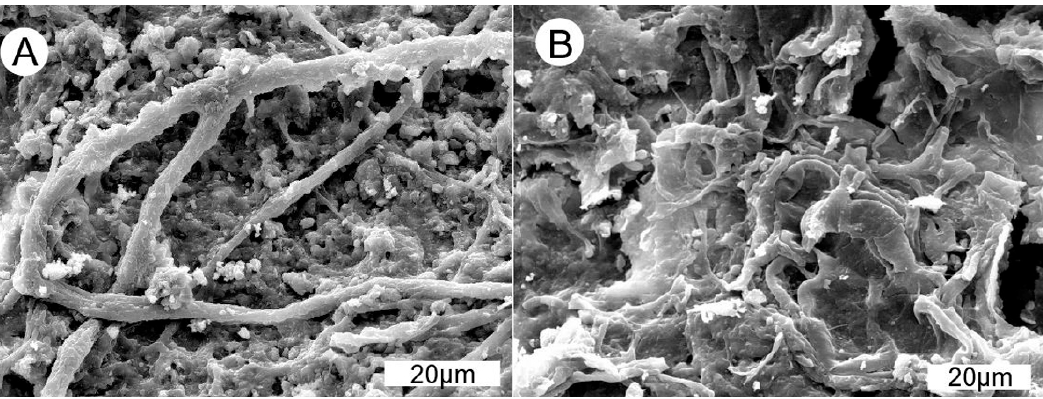
Figure 9. SEM images of silicified stromatolites, showing the presence of ( A ) filamentous and ( B ) unicellular microbes. Geosciences 2019 , 9 , x FOR PEER REVIEW 11 of 26